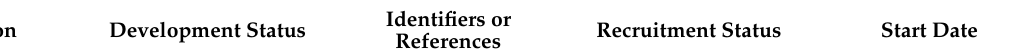
Table 1. Current therapeutic candidates that target MUC1